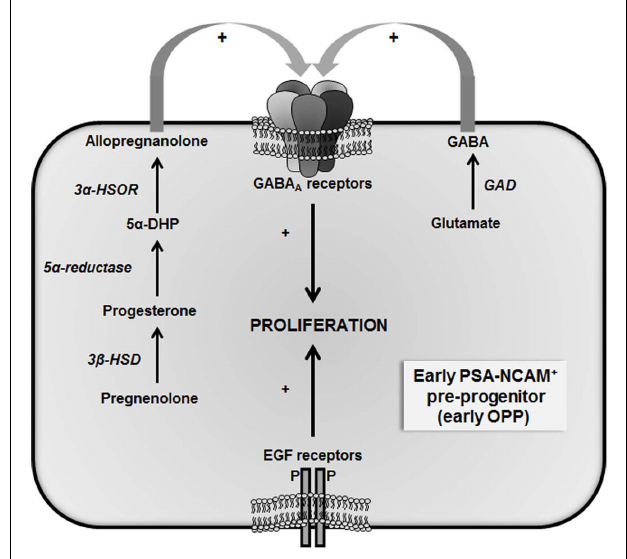
FIGURE 3 |Autocrine regulatory loop regulating the proliferation of early oligodendrocyte pre-progenitors (early OPP). Epidermal growth factor (EGF) is a potent mitogen for early OPP.These cells express GABA A receptors and synthesize GABA, which also stimulates their proliferation. Moreover, early OPP synthesize allopregnanolone, which at nanomolar concentrations, increases their proliferation via the modulation of GABA A receptors.Thus, OPP proliferation is regulated by two interacting autocrine signaling pathways (3 α -HSOR, 3 α -hydroxysteroid oxidoreductase; 3 β -HSD, 3 β -hydroxysteroid dehydrogenase; 5 α -DHP, 5 α -dihydroprogesterone; GAD, glutamate decarboxylase; adapted from Gago et al.,